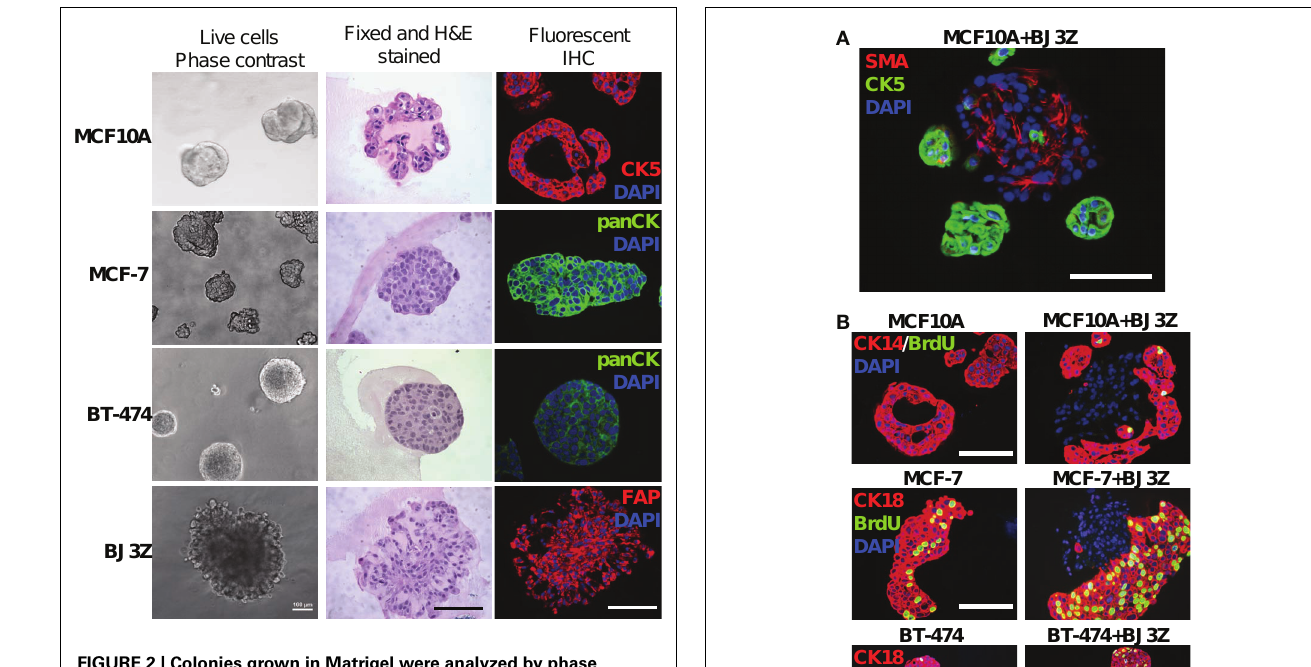
cells in mono-culture or co-culture with BJ3Z mouse stromal